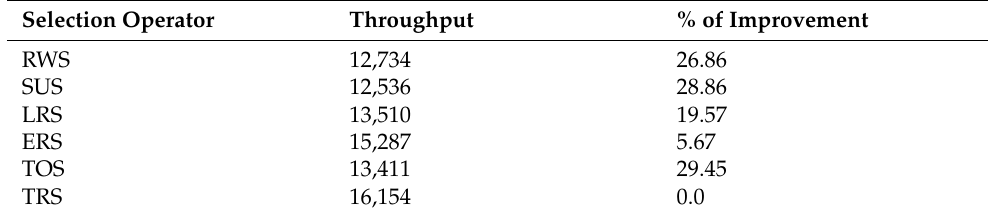
Figure 5. Total number of packets that reached the sink node. Table 6. Network throughput and improvement of TRS over other selection